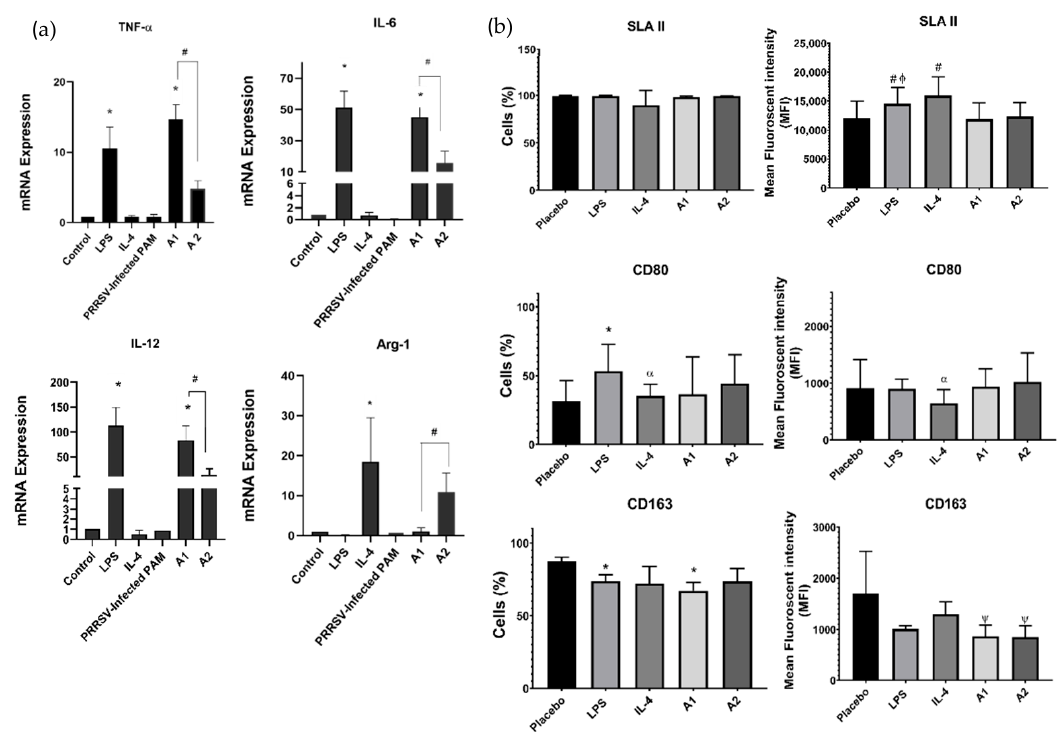
Figure 2. A1 drives M1 macrophages polarization and the expression of CD163 on PAMs was significantly decreased. ( a ) mRNA expression profile of M1 and M2 macrophages of PAMs-challenged by PRRSV-2 antigens measured by quantitative PCR (qPCR). A1 promote up-regulation the mRNA level of pro-inflammatory genes and down-regulate the anti-inflammatory genes. ( b ) The expressions of surface protein SLA II + , CD80 + and CD163 + in macrophages by flow cytometry. A1 decreased the cells percentage of CD163 + on PAMs. PAMs were treated by LPS, IL-4, A1, or A2 for 24 h. Untreated PAMs were used as control. * p < 0.05 compared to control group; α p < 0.05 compared to LPS group; ψ p < 0.05 compared to IL-4 group; # p < 0.05 compared to A1 group; φ p < 0.05 compared to A2 group. The data were analyzed by mean ± SEM, calculated from 3 pigs (duplicate each pig).